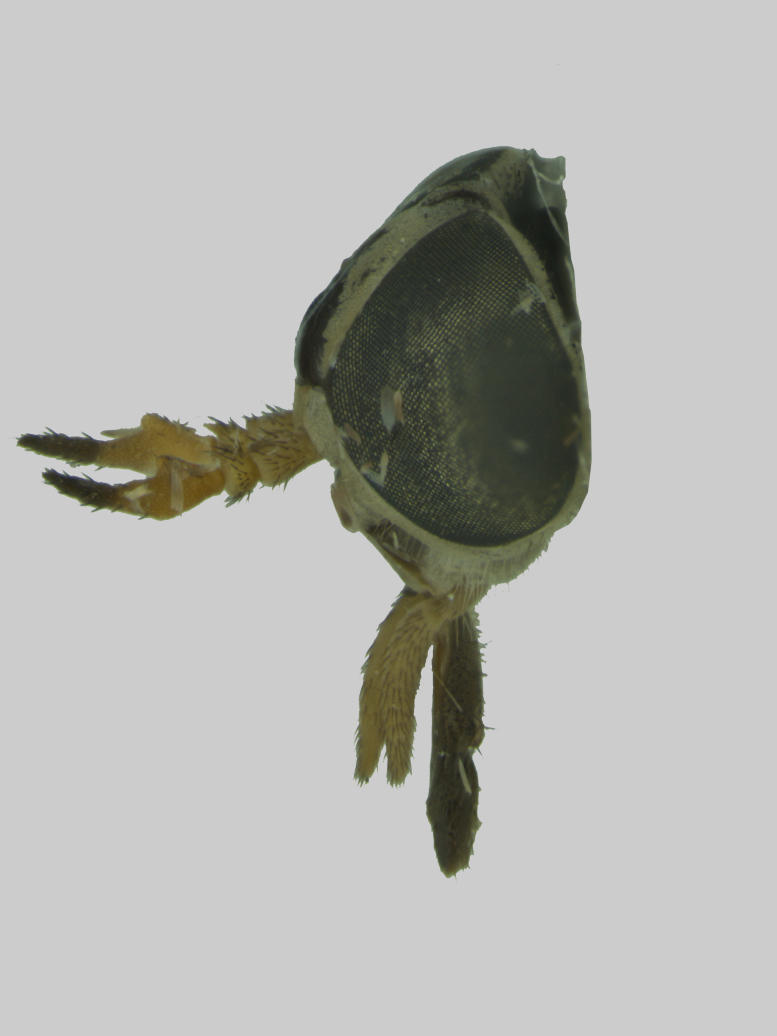
Head, lateral view.